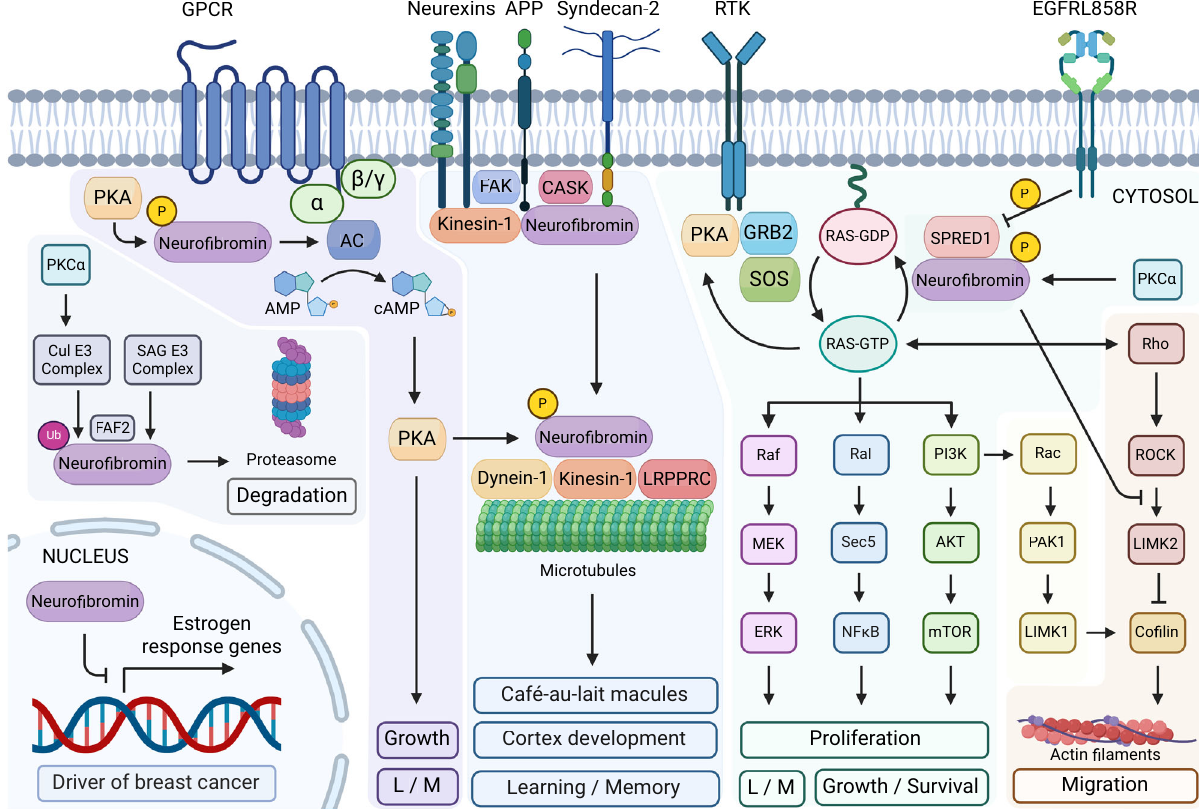
Fig. 3 Signaling pathways downstream of neuro fi bromin. Neuro fi bromin is involved in several cell signaling pathways, including the Ras/MAPK, Akt/ mTOR, Ral, ROCK/LIMK/co fi lin, and cAMP/PKA pathways. From the cytosol to the nucleus neuro fi bromin regulates many fundamental cellular processes, such as expression of estrogen response genes, proliferation, migration, cortex development, learning and memory